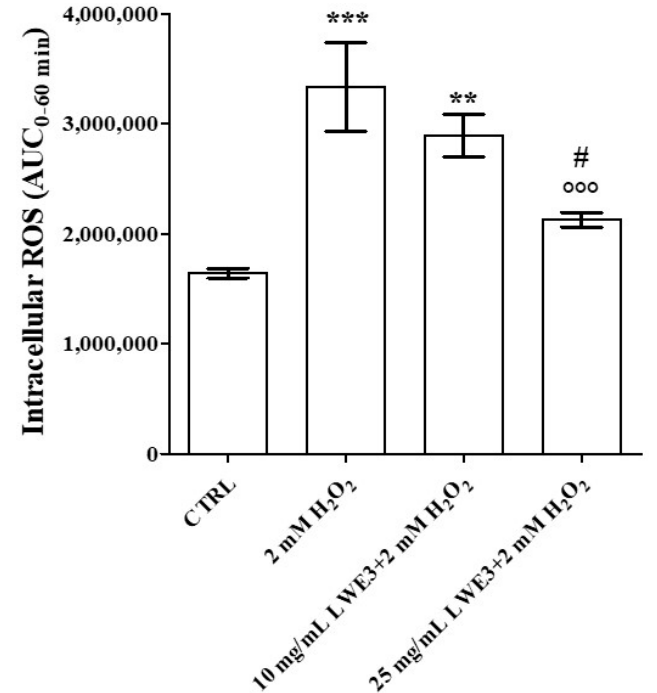
Figure 4. Total amount of intracellular reactive oxygen species in the control condition (CTRL) in presence of 2 mM H 2 O 2 , of 10 mg mL − 1 LWE3 plus 2 mM H 2 O 2 and of 25 mg mL − 1 LWE3 plus 2 mM H 2 O 2 during 60 min, expressed as Area Under Curve (0–60 min) . Data are reported as the mean ± S.E.M. of at least 3 independent experiments. LWE3 = lees of Magliocco Canino in water (pH = 2)/ethanol. *** p < 0.001 vs. CTRL, ** p < 0.01 vs. CTRL, °°° p < 0.001 vs. H 2 O 2 , # p < 0.05 vs. 10 mg mL − 1 LWE3 + 2 mM H 2 O 2 , ANOVA followed by Tukey post-test.